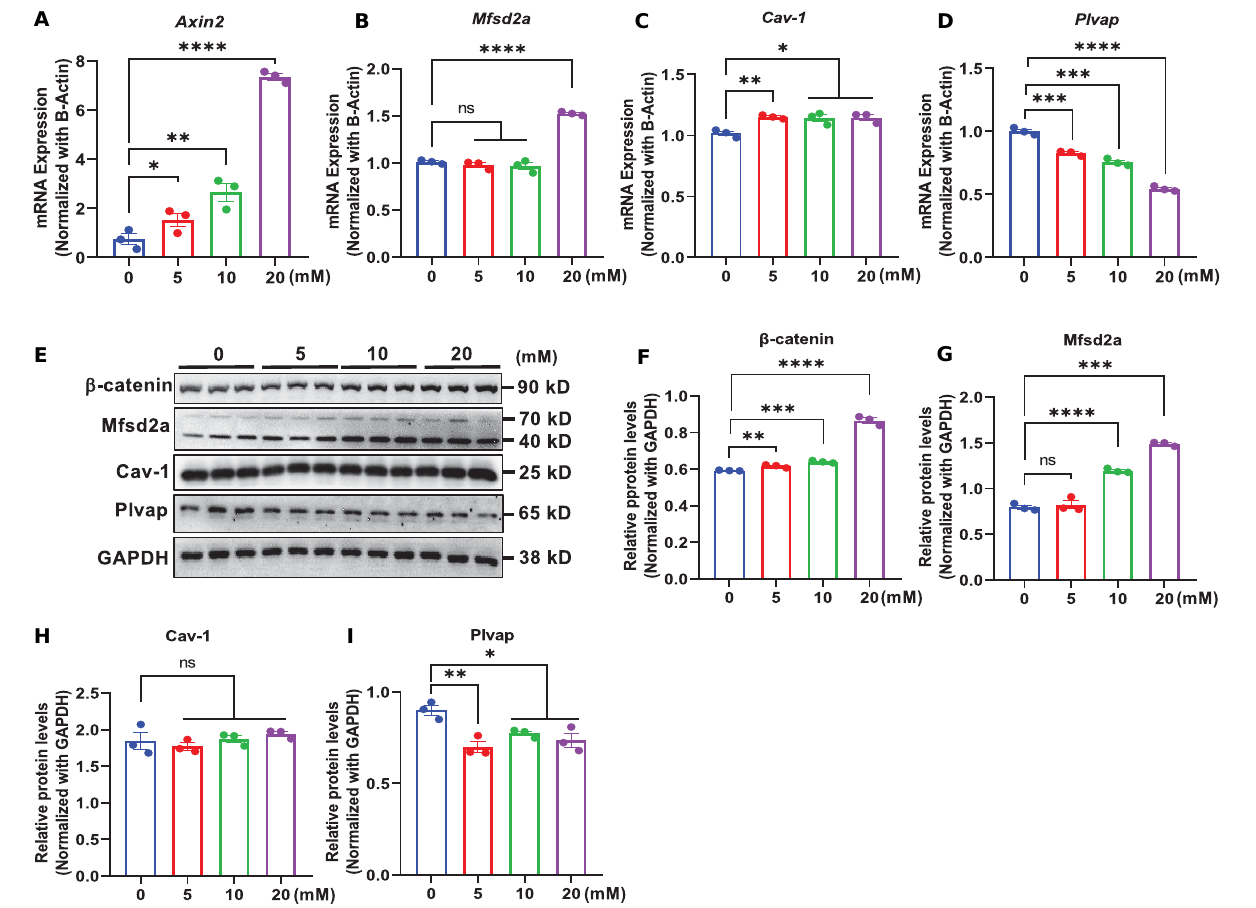
FIGURE 6 | GSK-3 β inhibitor-induced activation of β -catenin signaling regulates the expression of transcytosis-related genes in brain endothelial cells. bEnd.3 cells were incubated with LiCl (0, 5, 10, and 20 mM) for 24 h and then subjected to various measurements. (A–D) qRT-PCR measurement of the mRNA levels of Axin2 , Mfsd2a , Cav-1 , and Plvap normalized with that of β -actin . (E) Western blot measurement of β -catenin, Mfsd2a, Cav-1, and Plvap. (F–I) Relative protein levels of β -catenin, Mfsd2a, Cav-1, and Plvap normalized with that of GAPDH. Data are mean ± SD. n = 3 per group. ns = not significant, P > 0.05, ∗ P ≤ 0.05, ∗∗ P ≤ 0.01, ∗∗∗ P ≤ 0.001, ∗∗∗∗ P ≤